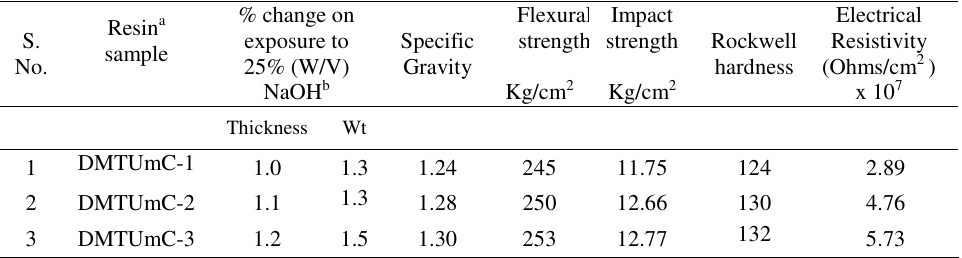
Table 5 . Mechanical and chemical properties of glass-reinforced DMTUmC-HMTA composites